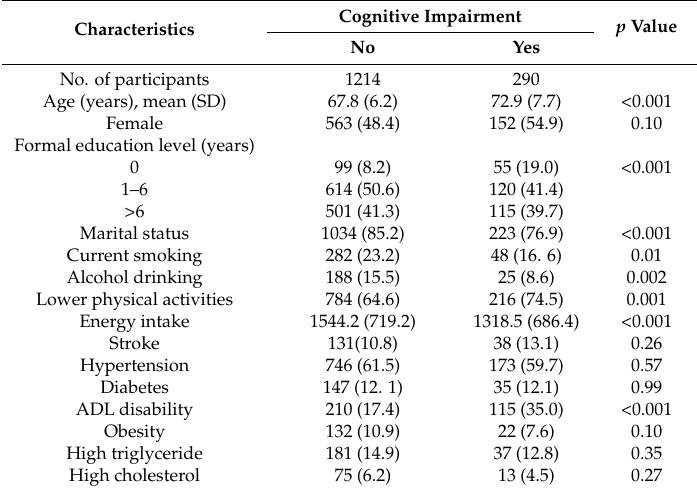
Table 1. Characteristics of study participants by cognitive status ( n = 1504) a